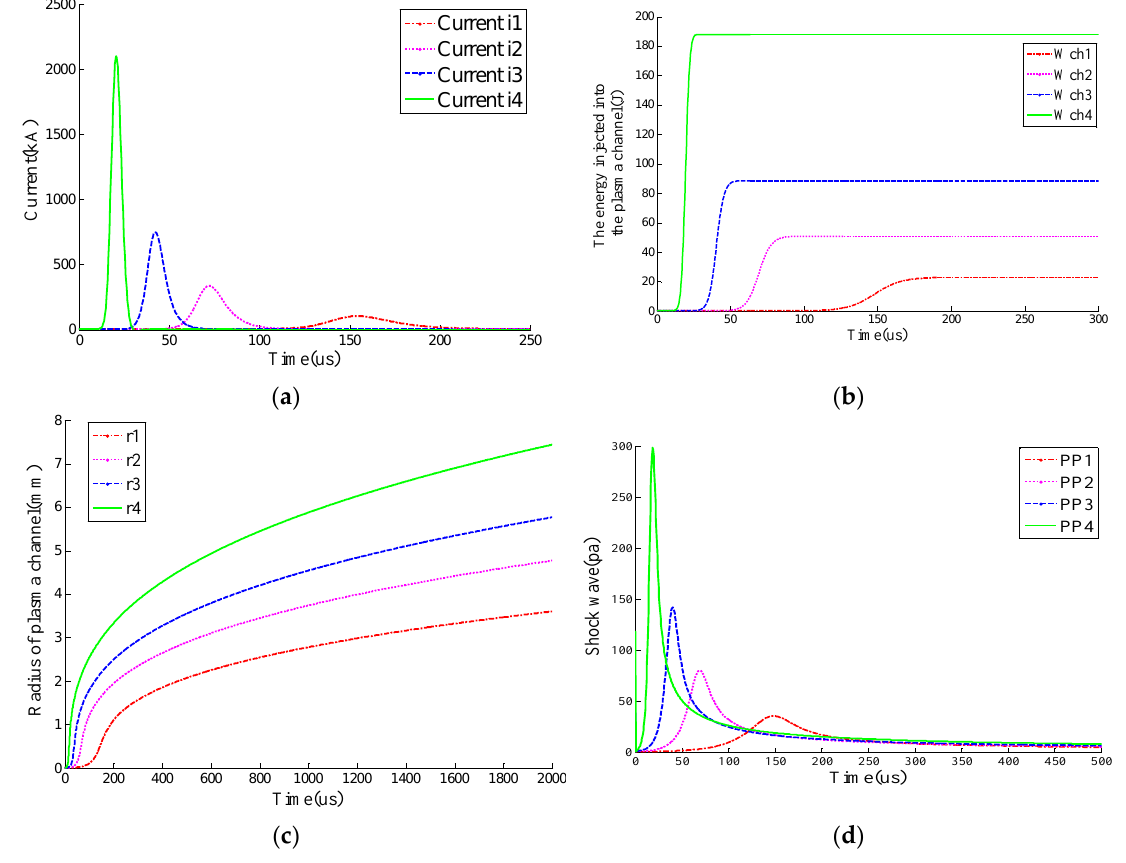
Figure 9. ( a ) Current waveform of plasma channel, ( b ) the energy injected into plasma channel, ( c ) radius of plasma channel, and ( d ) shockwave. L = 5μH , C = 0.5 μF , U (kV): U1 = 10, U2 = 15, U3 = 20, U4 = 30.